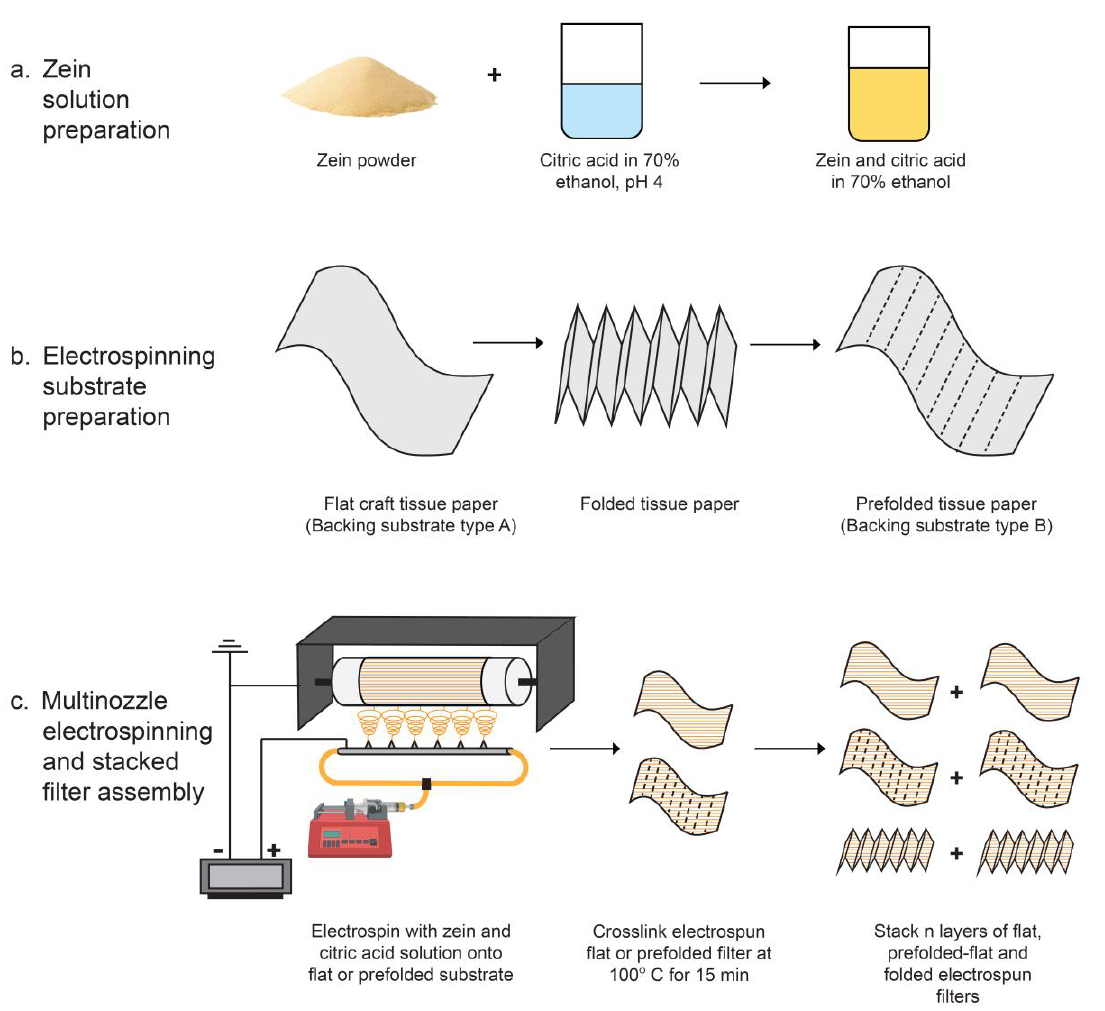
Figure 1. Schematic of the process for preparing compostable multilayer electrospun air filter: ( a ) zein solution preparation, ( b ) electrospinning substrate preparation, and ( c ) multinozzle electrospinning and stacked filter assembly.